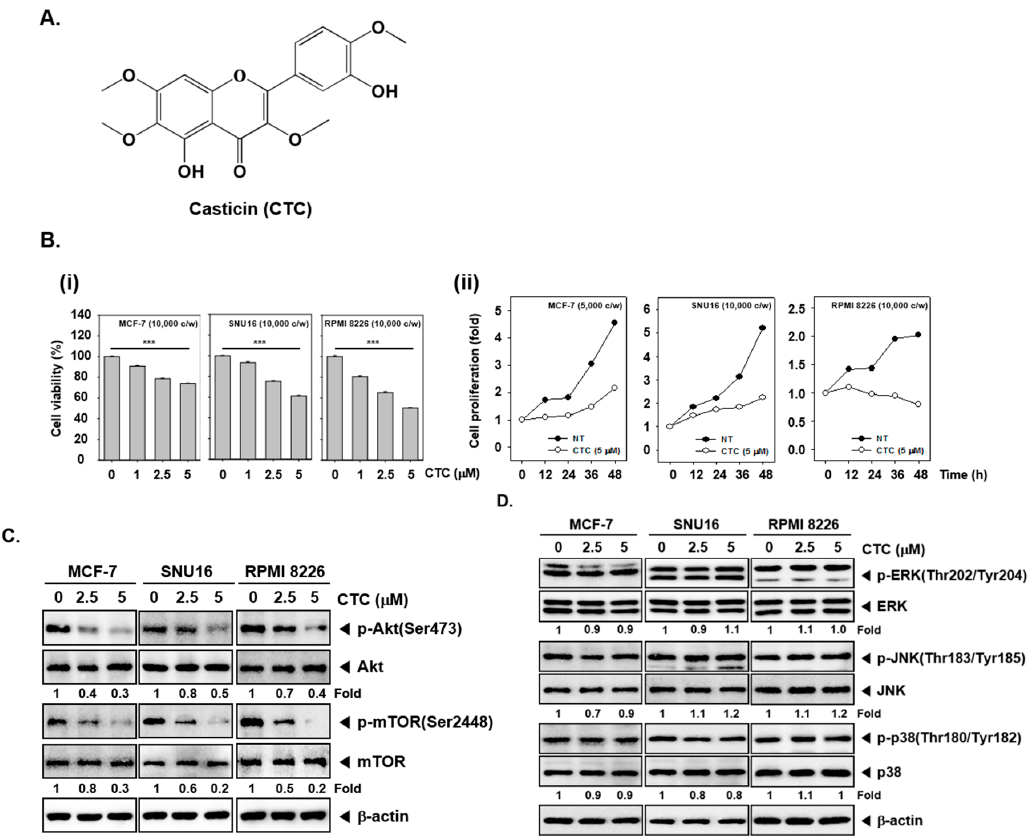
Figure 1. CTC inhibits cell viability and proliferation through Akt/mTOR signaling pathway